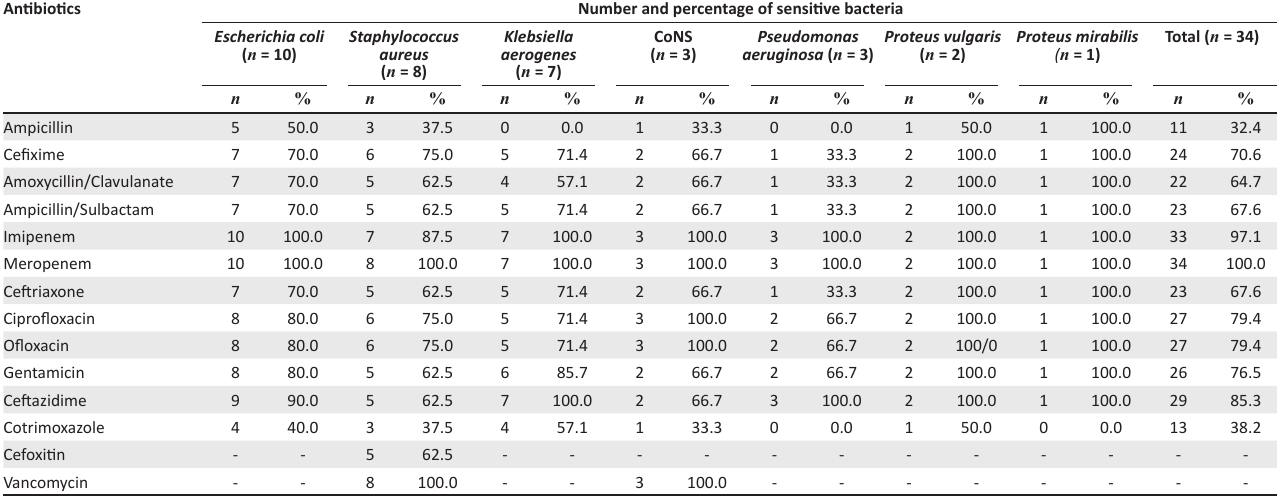
TABLE 5: Antibiotic susceptibility pattern of isolates from bloodstream infection cases at the Federal Teaching Hospital, Ido-Ekiti, Nigeria, between June 2020 and February 2021. Antibiotics Number and percentage of sensitive bacteria